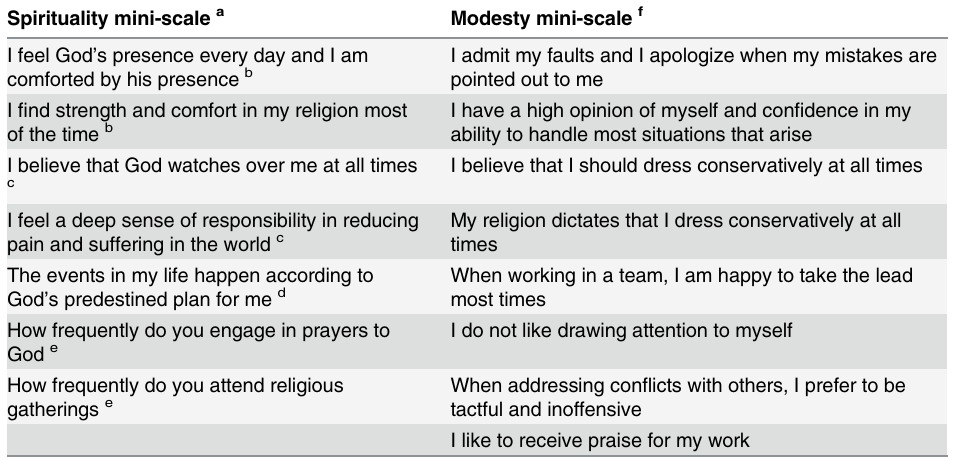
Table 1. Mini scales for the measurement of spirituality and modesty, Nigeria,